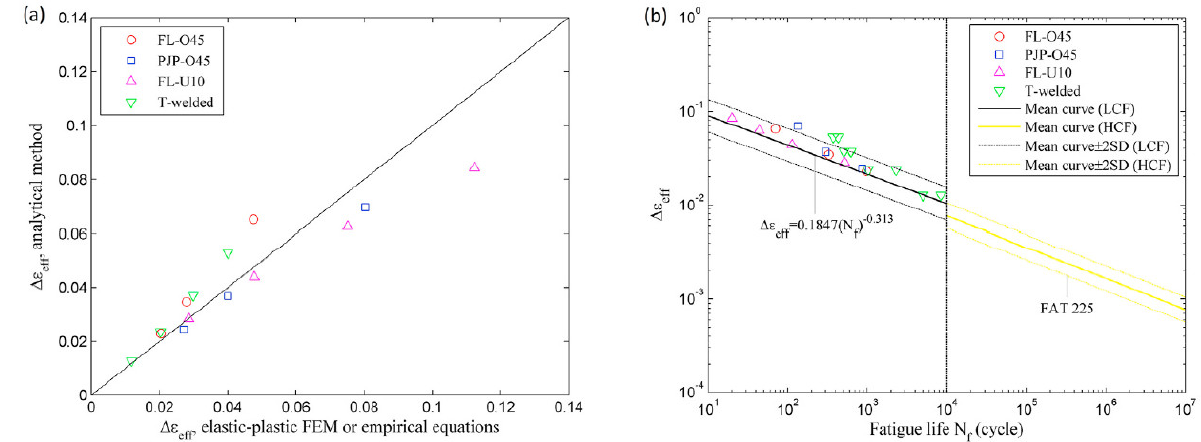
Figure 18. Results of procedures of estimating the ENSN range, proposed in [70]. ( a ) ESED approach vs elastic-plastic FEM or empirical equations; ( b ) ENSN ranges estimated by ESED approach plotted against fatigue test results. Reprinted with permission from ref. [70]. Copyright 2021